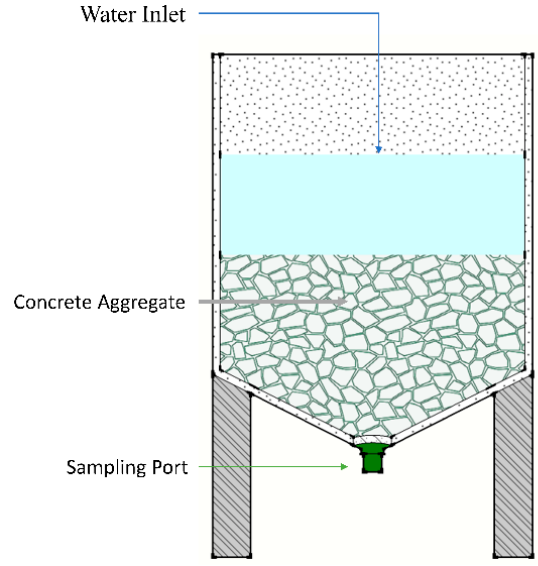
Figure 1. Schematic diagram of the batch test reactor.